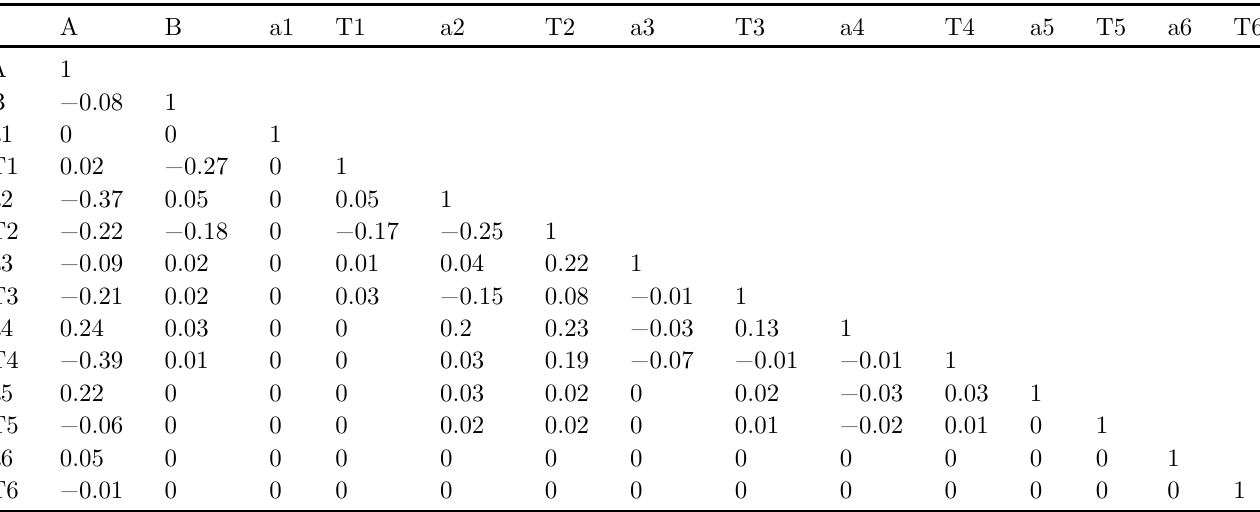
Table C4. The 6-group correlation matrix obtained in processing of the model decay curve calculated with the help of the 6-group DN “ input dataset ” ( A = 1000; B = 100).